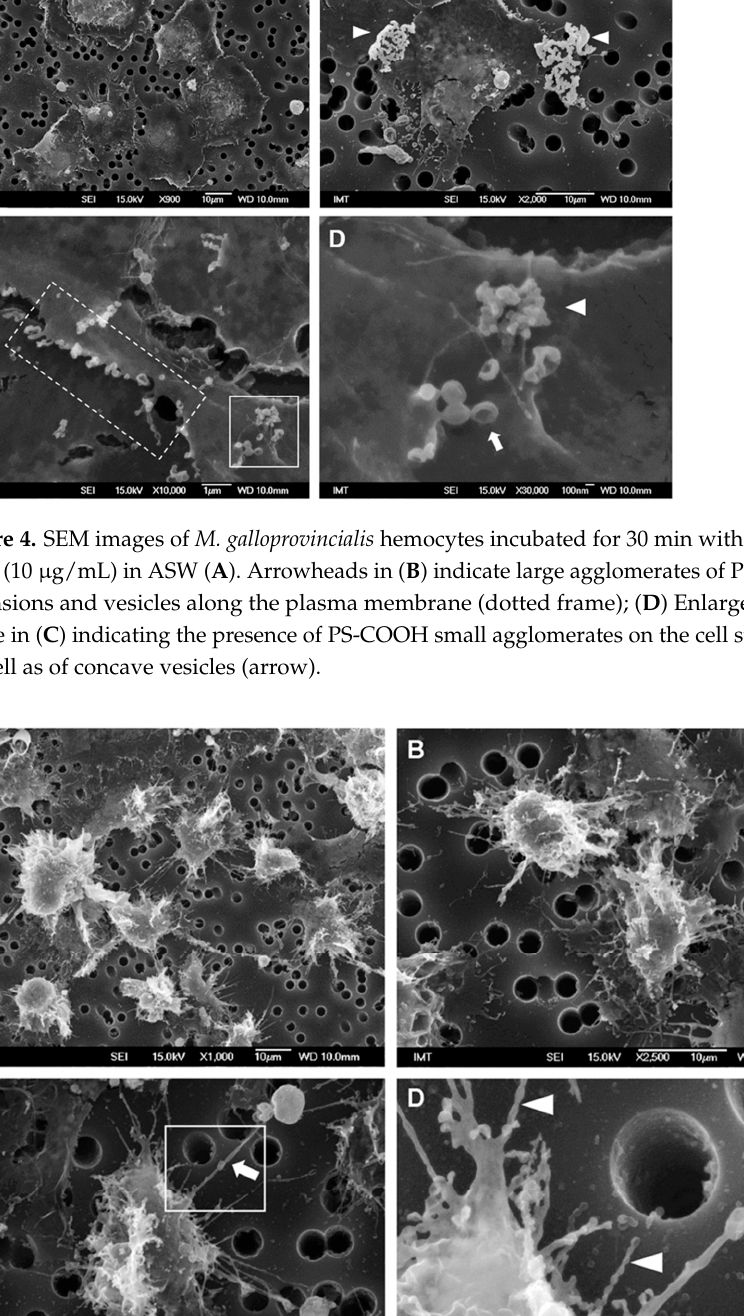
Figure 6. Effects of PVP ‐ AuNPs in ASW on hemocyte: lysosomal membrane stability (LMS) ( A ), phagocytosis ( B ) and extracellular ROS production ( C ).